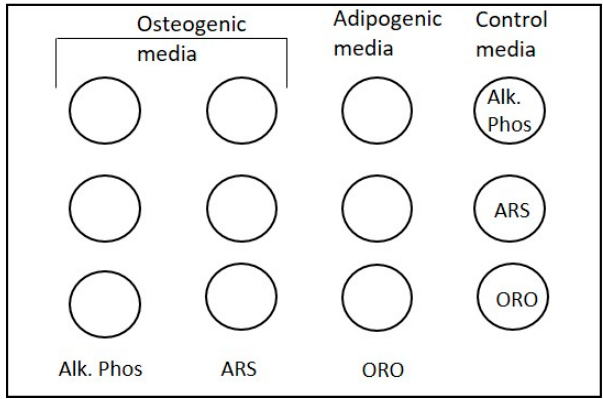
Figure 1. The setup for differentiation assay for GMSCs on electrospun scaffolds on a 12-well plate. Each well had 20,000 GMSCs overlaid on top of identical e-PCL scaffolds. Cells in the first two columns were incubated in osteogenic media; third column had adipogenic media and the fourth column had cells in maintenance (control) media. After three weeks, the cell-scaffold constructs were stained for Alk. Phos (alkaline phosphatase); ARS (alizarin red S) and ORO (Oil Red O). Control wells were also stained as specified. This setup allows for controls of media and stain specificity.